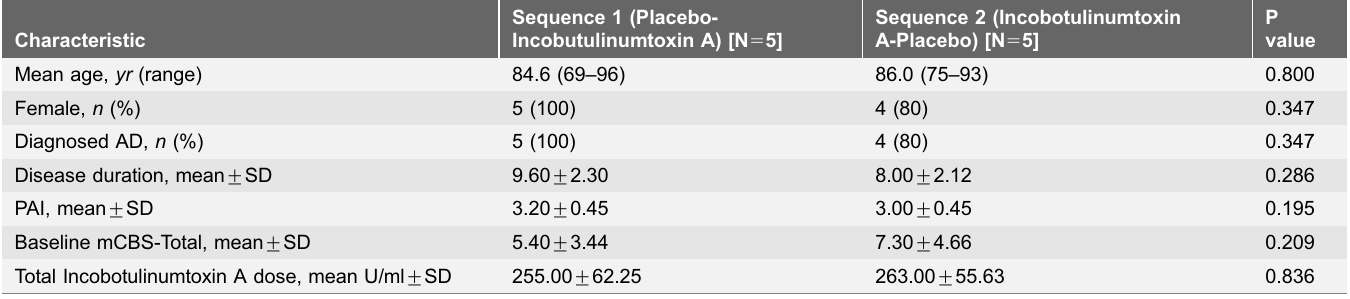
respectively. There was reduction in cleaning of the left and right palms of the significance. By contrast, ANOVA comparing baseline to 6-week effects found no significant differences between treatment and placebo in mCBS total score (p 5 0.2), though significant improvement was present in the dressing component of the mCBS (p 5 0.01). No period or sequence effects were detected. Models’ fits were improved without substantial loss of parsimony with the incorporation of subject random effects, as demonstrated by reductions in the Bayesian information criterion, suggesting that between-individual heterogeneity in disease and response was an important consideration in explaining Incobotulinumtoxin A treatment effects ( S2 Table